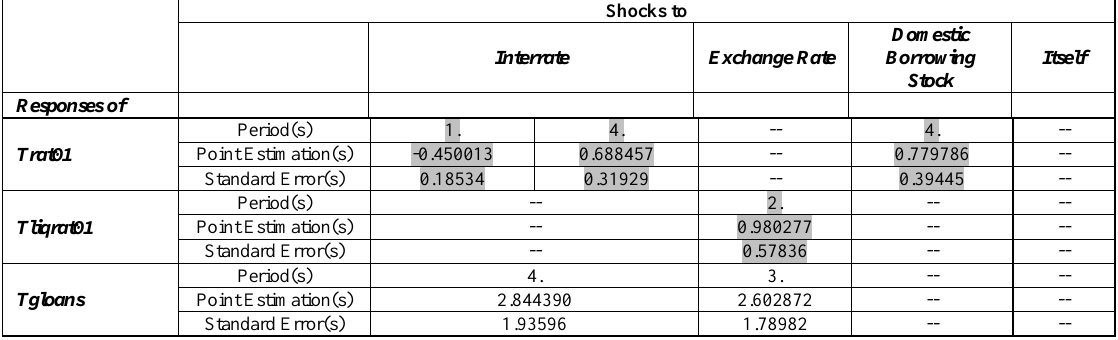
Table 3. The Summary of the IRFs of TBS (Excluding Foreign Banking